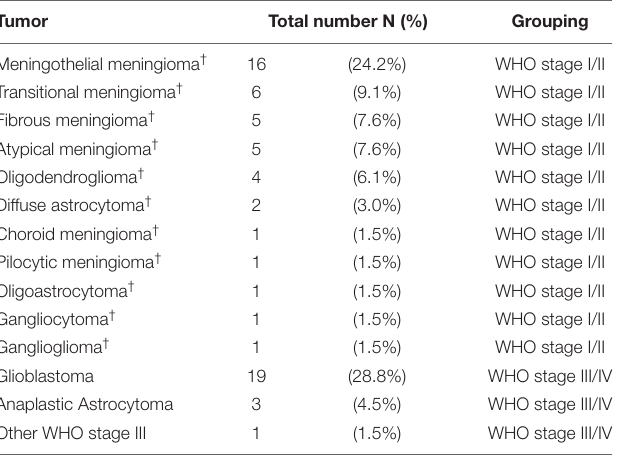
TABLE 1 | Classification of patients in the respective WHO stage group ( N = 66).